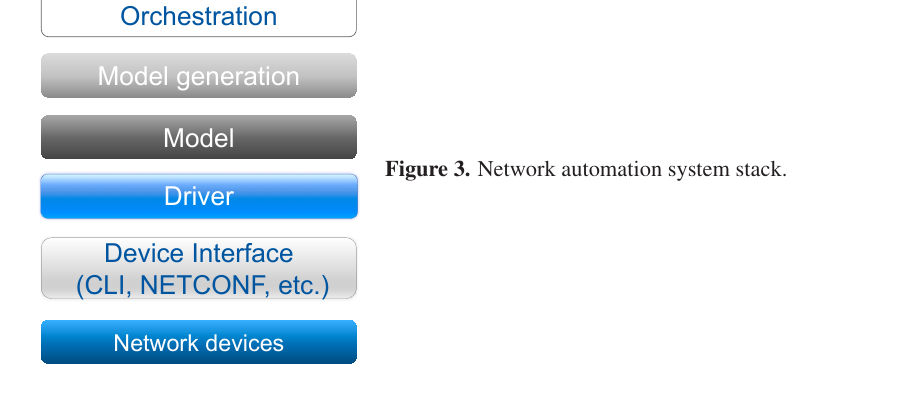
Figure 3. Network automation system